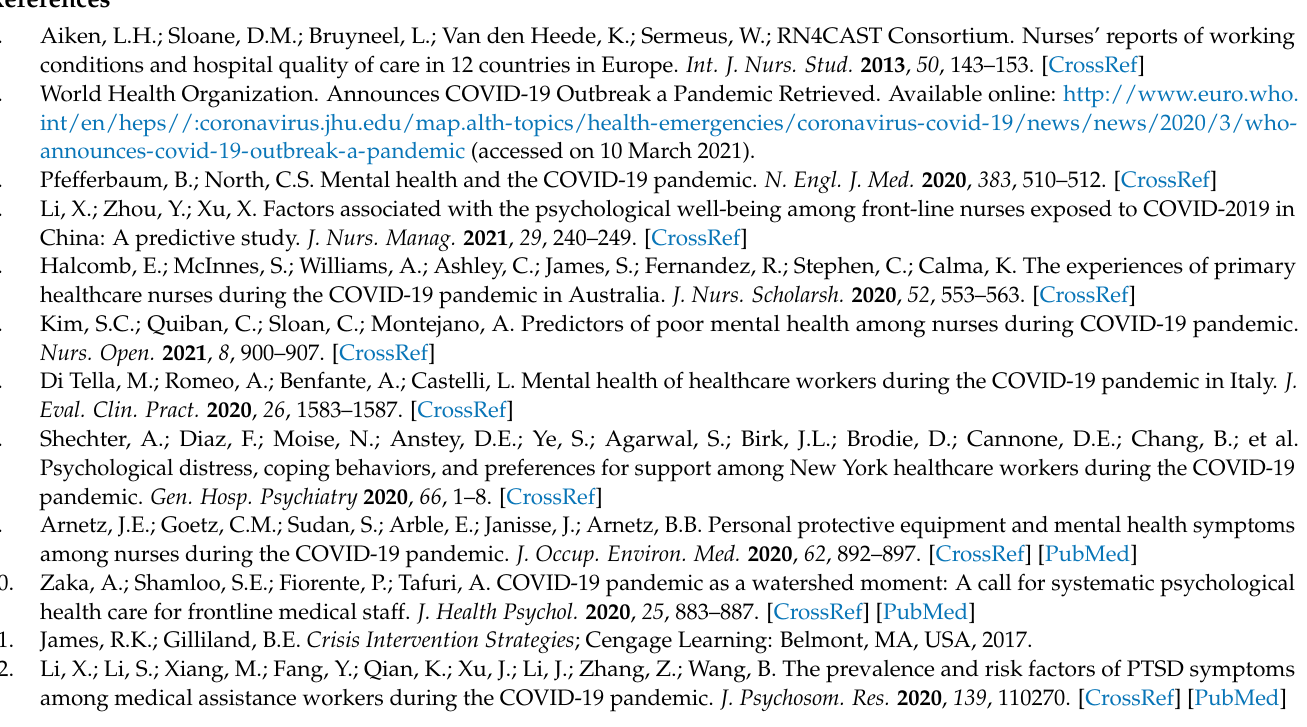
Table S3: Quality assessment result of observational studies ( n = 23) using the questioner according The Agency for Healthcare Research and Quality (AHRQ); Figure S1: Funnel plot for meta-analysis of the prevalence of depression; Figure S2: Funnel plot for meta-analysis of the prevalence of depression (A: for all tools; B: only for